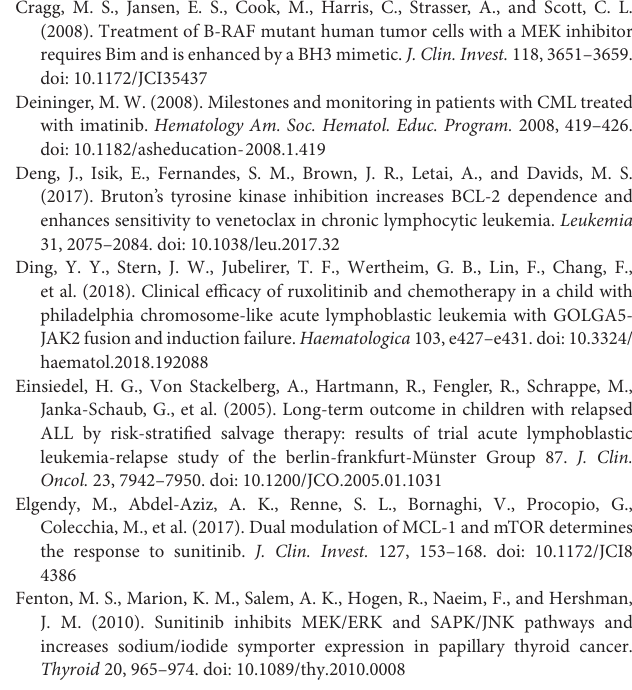
Supplementary Figure 1 | (A) ROC curve analysis using the values of (cid:49) %priming in NALM-6 and SEM cell lines establishing 10% as the cell death threshold for responders and non-responders. (B) Correlation between (cid:49) %priming and %cell death analyses. Supplementary Figure 2 | (A) Western blot analysis of phospho-ERK1/2 and phospho-BIM in NALM-6 cell line after 16 h of treatment with trametinib 100 nM. (B) Western blot analysis of BAK and BAX in NALM-6 cell line after 16 h of treatment with trametinib 100 nM. Quantification of optical density for each protein was normalized to actin, and fold-change was calculated comparing to protein expression in the control condition. All results are expressed as the mean ± SEM of at least three biologically independent replicates. Statistical significance was calculated using Student’s t -test compared to control condition and considering ∗ p < 0.05 and ∗∗ p < 0.01. Supplementary Figure 3 | ABT-199 and S63845 induce cytotoxicity in the SEM cell line. Cytotoxicity expressed as percentage of dead cells after 72 h of treatment with 100 nM ABT-199 and 1,000 nM S63845, as assessed by an Annexin V/DAPI staining. All results are expressed as the mean ± SEM of at least three biologically independent replicates. Statistical significance was calculated using Student’s t -test compared to control condition and considering ∗ p < 0.05 and ∗∗ p < 0.01. Supplementary Figure 4 | (A) Western blot analysis of phospho-ERK1/2 and phospho-BIM in the SEM cell line after 16 h of treatment with sunitinib 100 nM and 1,000 nM. (B) Western blot analysis of BAK and BAX in SEM cell line after 16 h of treatment with sunitinib 100 nM and 1,000 nM. Quantification of optical density for each protein was normalized to actin, and fold-change was calculated comparing to protein expression in the control condition. All results are expressed as the mean ± SEM of at least three biologically independent replicates. Statistical significance was calculated using Student’s t -test compared to control condition and considering ∗ p < 0.05 and ∗∗ p < 0.01. Supplementary Figure 5 | BCL-2 family of proteins expression in BCP-ALL PDX cells after sunitinib treatment. Western blot analysis for anti-apoptotic and BIM proteins in BCP-ALL PDX cells after 16 h of treatment with sunitinib 100 nM and sunitinib 1,000 nM. Quantification of optical density for each protein was normalized to actin, and fold-change was calculated comparing to protein expression in the control